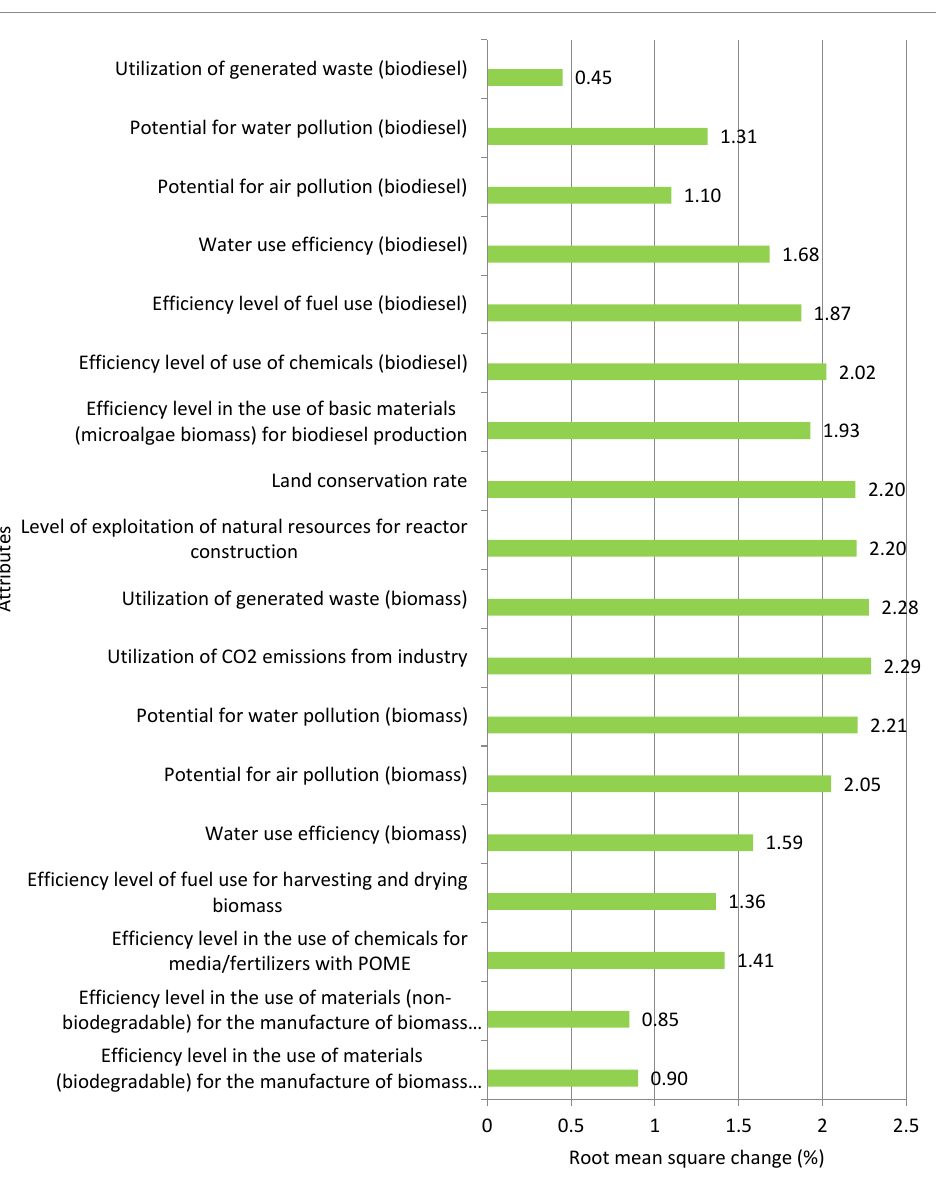
Fig. 2: Leverage of environmental attributes